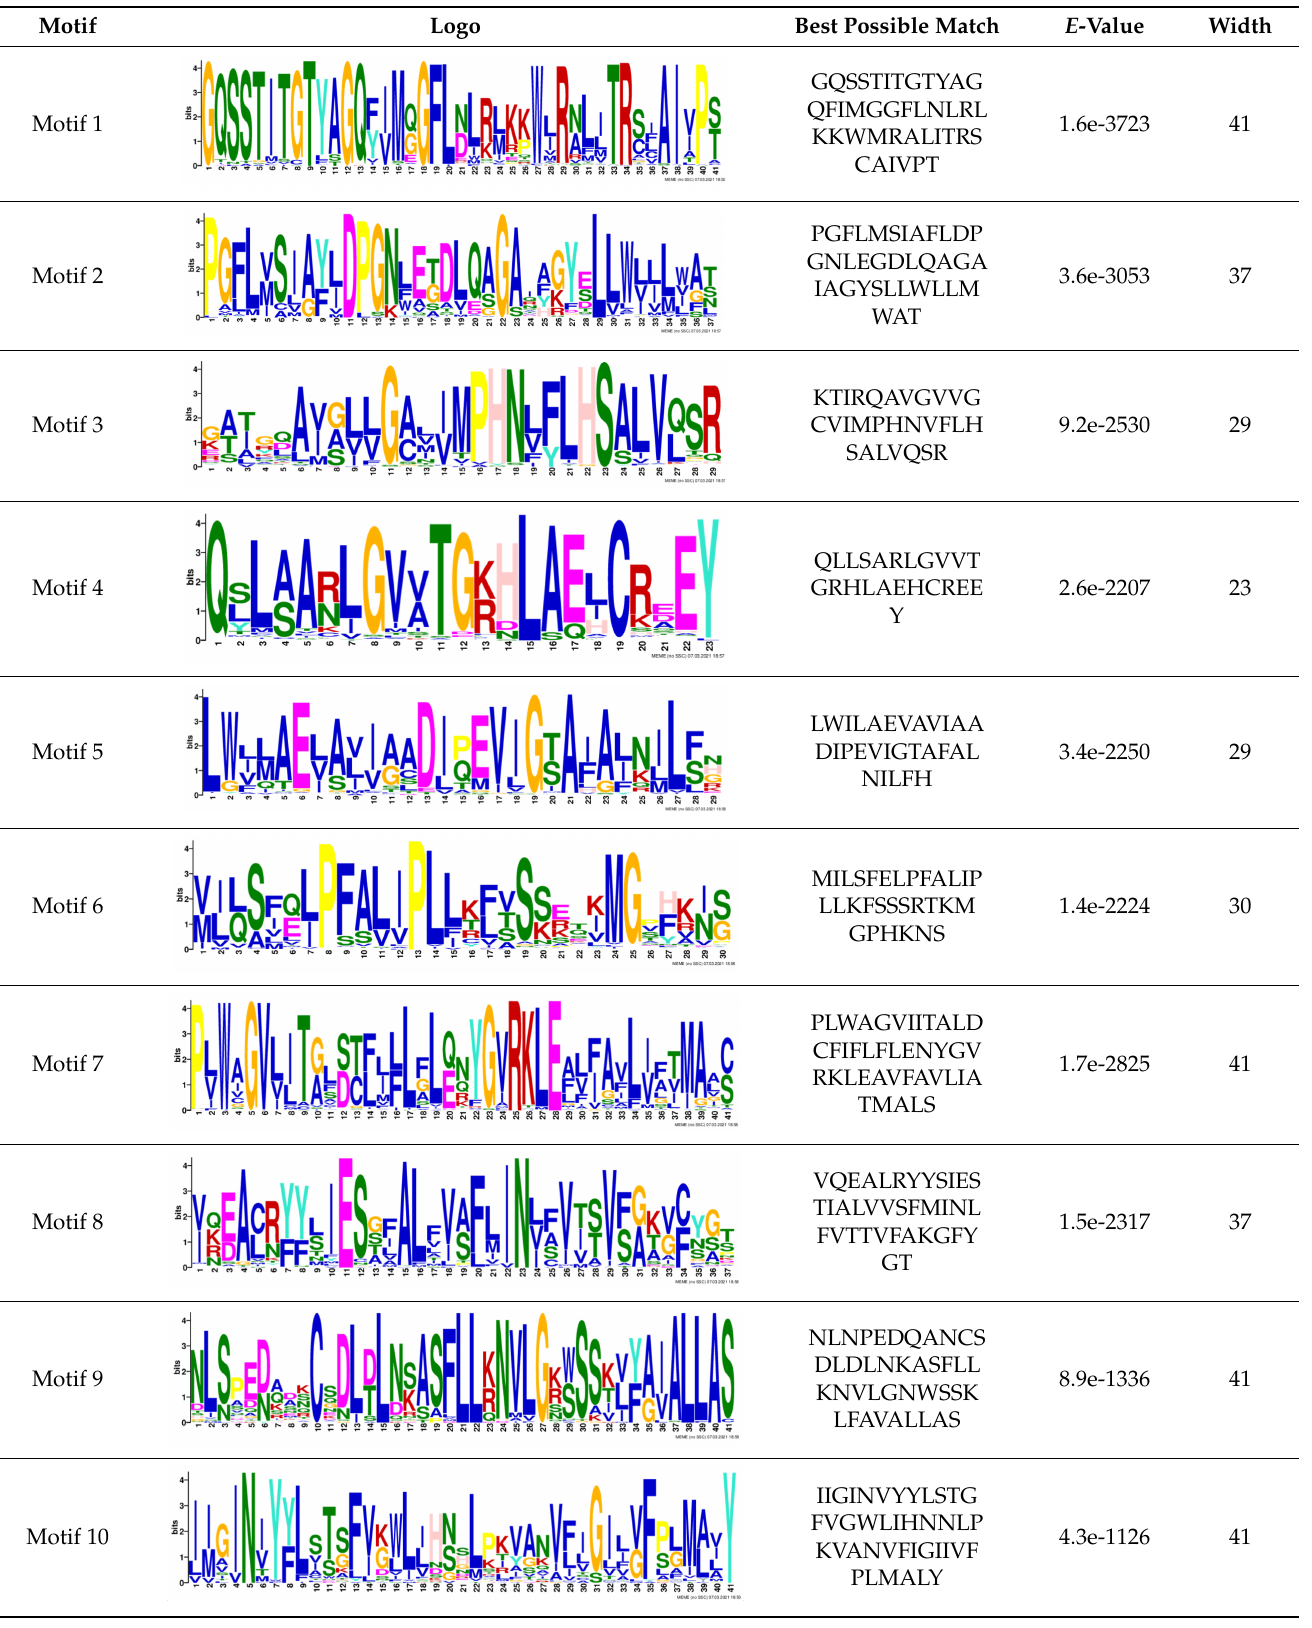
Table 1. List of the putative motifs of Nramp proteins. Motif